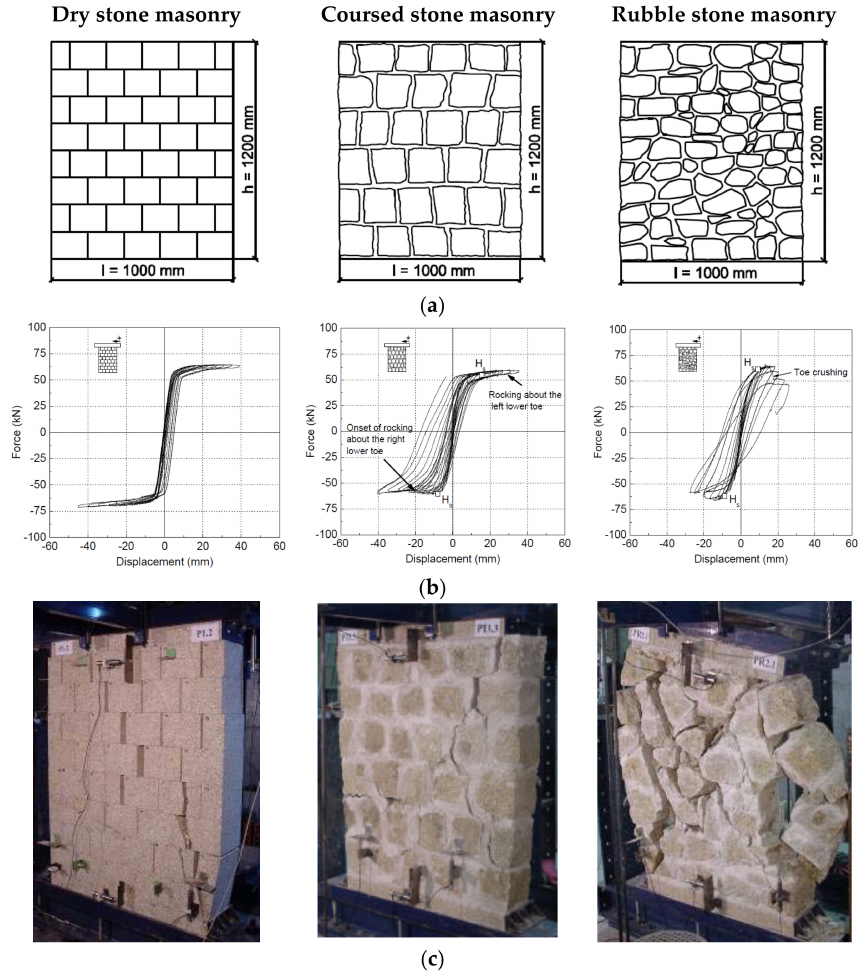
Figure 3. Experimental results on stone masonry shear walls [21]: ( a ) specimen geometries; ( b ) force − displacement diagrams; ( c ) failure